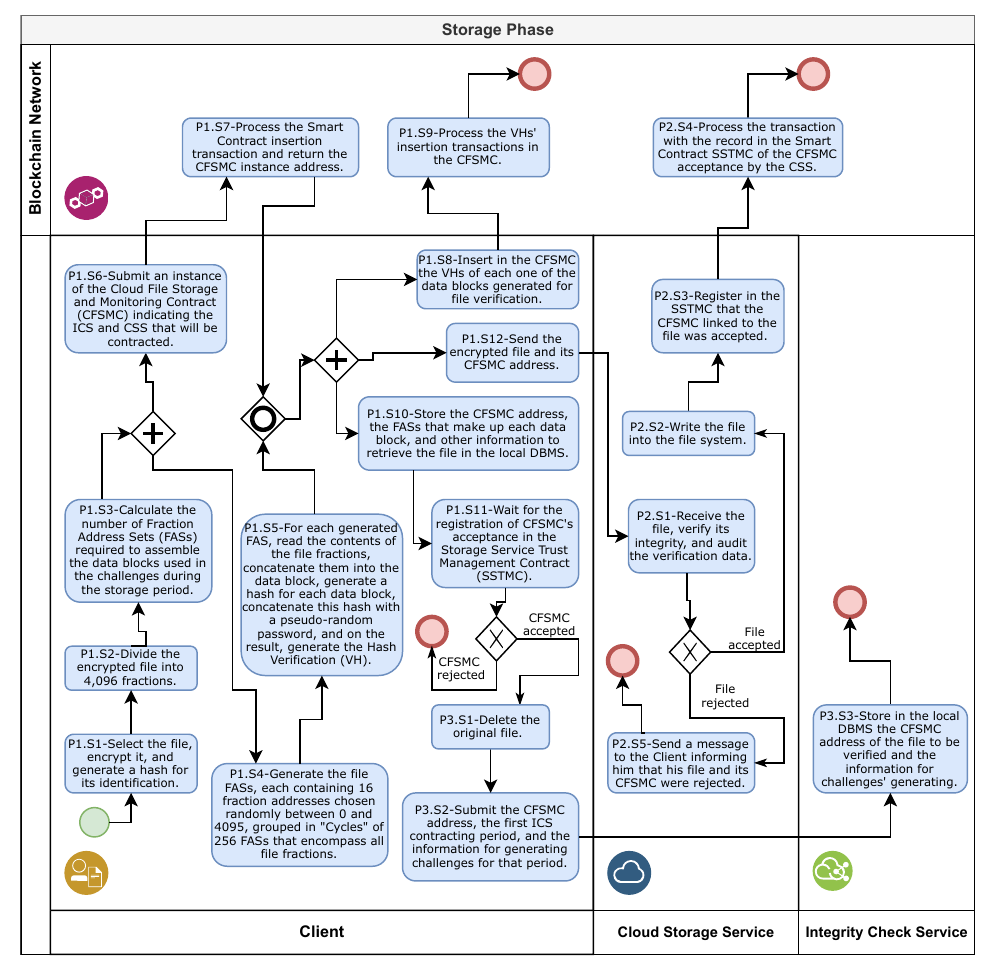
Figure 5. Storage phase